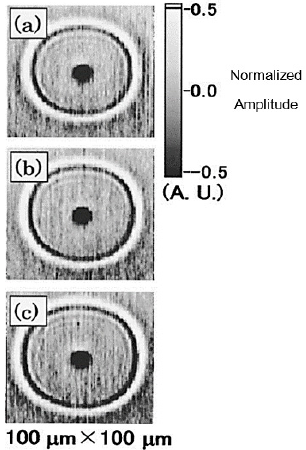
Figure 19. Experimental images of surface acoustic wave fronts for a Si substrate coated with a 50 nm gold film taken with 100 × 100 pixels at delay times, ( a ) 7.9, ( b ) 8.5, and ( c ) 9.1 ns [127]. These images took around 4 min to be produced.